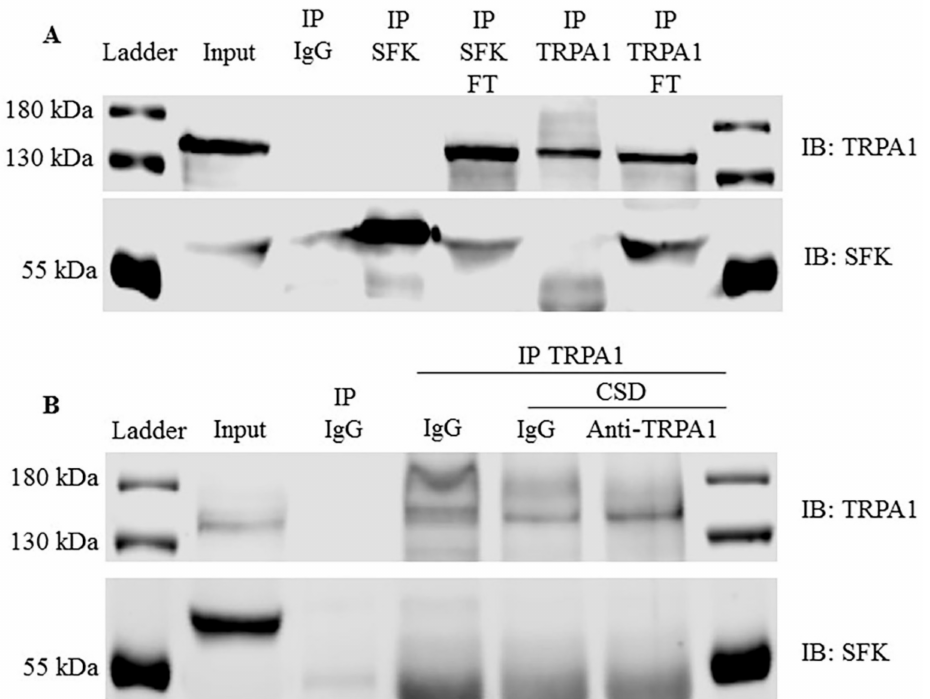
Figure 6. CSD was unlikely to promote the physical interaction between TRPA1 and SFKs in rat cere- bral cortices. ( A ) Co-immunoprecipitation between TRPA1 and SFKs in untreated rat cerebral cortices. Either TRPA1 or SFKs was immunoprecipitated (IP) followed by immunoblotting (IB) of the pull- down of TRPA1/SFKs with SFKs/TRPA1. FT: flow-through during IP. ( B ) Co-immunoprecipitation between TRPA1 and SFKs in rat cerebral cortices treated with IgG or anti-TRPA1 antibody (Anti- TRPA1) at 0.8 µ g with or without 2 M K + -induced CSD. TRPA1 was immunoprecipitated followed by immunoblotting of the pull-down of TRPA1 with SFKs. IgG was used for pull-down in IP as a negative control in ( A , B